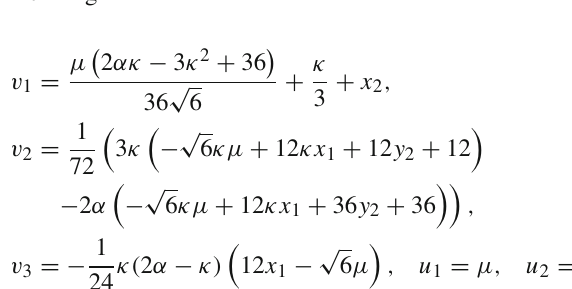
is a saddle point 2